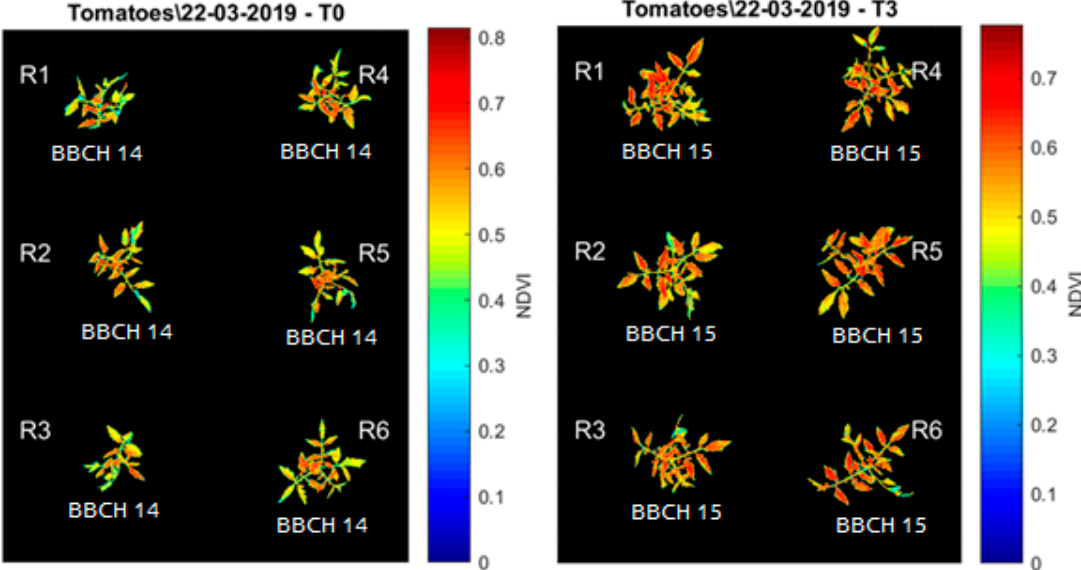
Figure 6. Example of vegetation indices obtained through the Parrot Sequoia camera and segmentation algorithm. NDVI image and phenological state (BBCH scale) of the T0 treatment (left) and the T3 treatment (right).